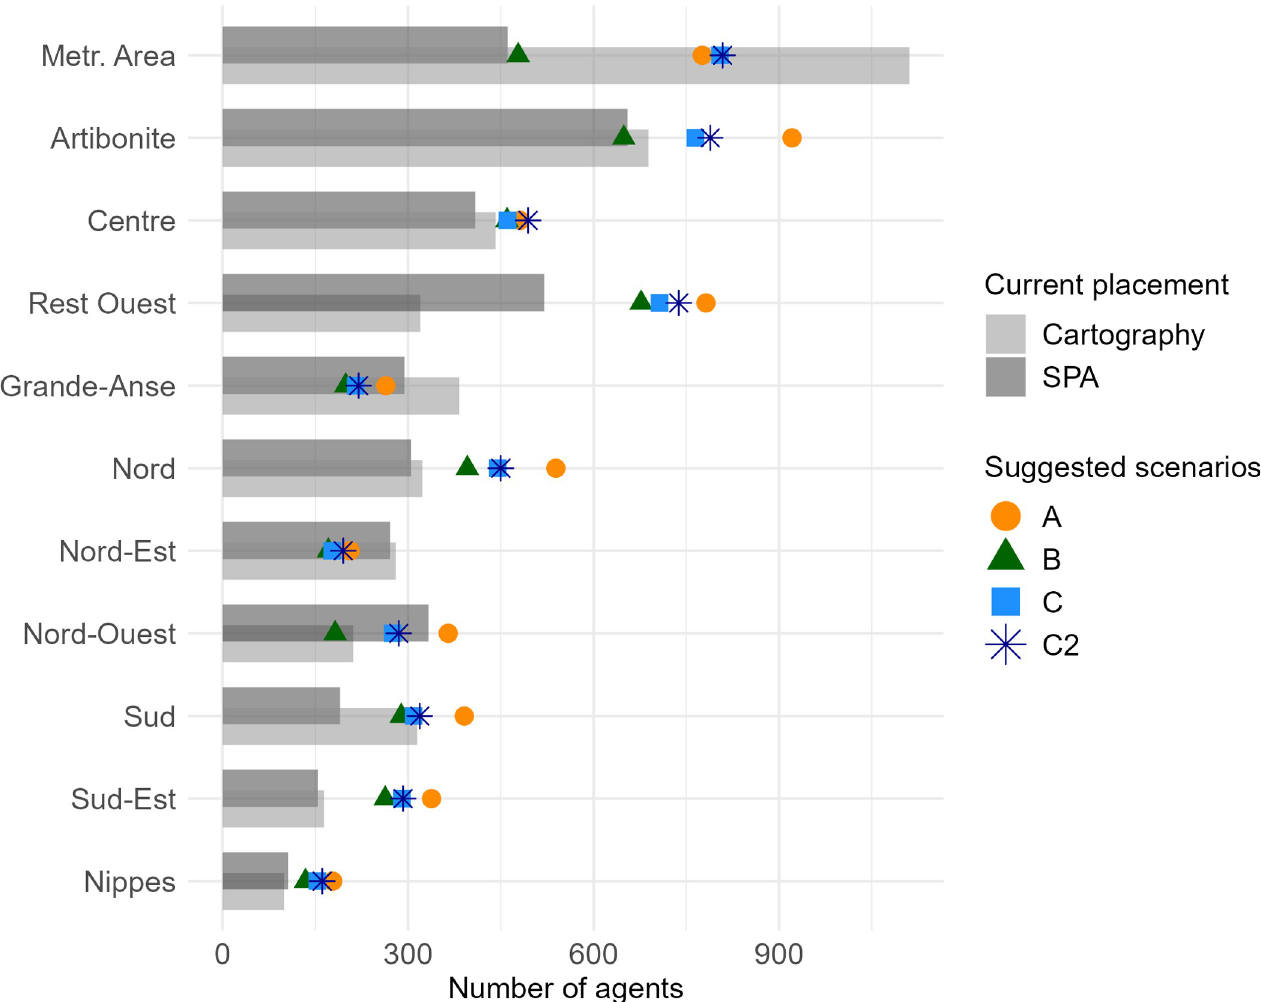
Fig 4. Comparison by department of the current number of CHWs according to the SPA survey [31] and the CHW mapping (“Cartography”, [13]), and the number of CHWs suggested in scenarios A, B, C and